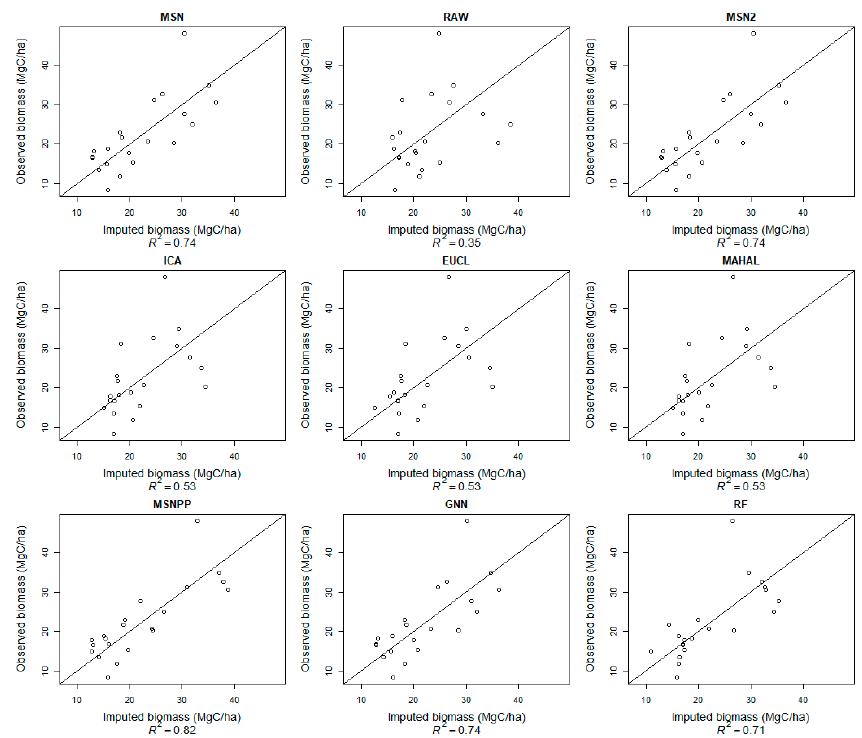
Figure 2. Bivariate relationships between the LiDAR metrics and biomass C stock of Pinus halepensis plantations at Los Cuadros (Murcia, Spain). In all figures, the linear 1:1 line has been fitted. For these equations, the R 2 value is included (see Table 3 for RMSE values). Remote Sens. 2018 , 10 , x FOR PEER REVIEW